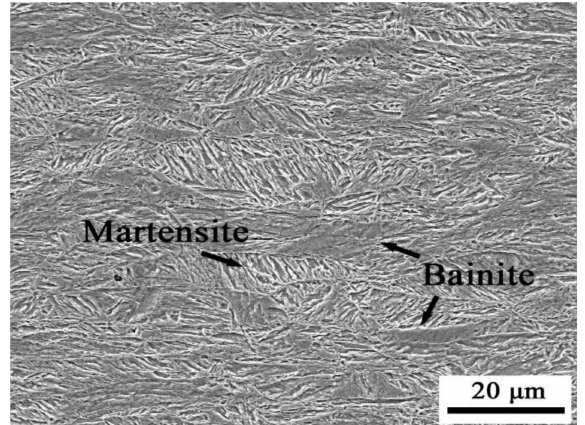
Figure 2. SEM micrographs of one of the three samples after DQ.